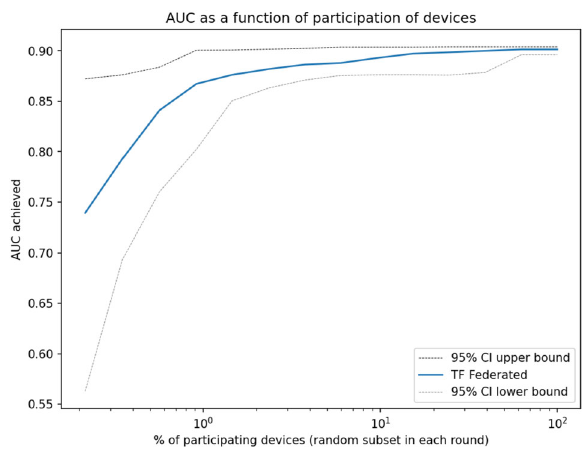
Fig. 1 Area under the ROC curve (AUC) as a function of fraction of participants in each federated (server) round of learning for replicated model of SARS-CoV-2 and Cancer. Shown in log scale to highlight details at the low participation levels. We see that even at a 2% participation rate, the model still achieves 99% of the maximum attainable AUC. We observe this pattern across all the datasets studied. 80% of the whole dataset was used to train the model and the rest 20% used for